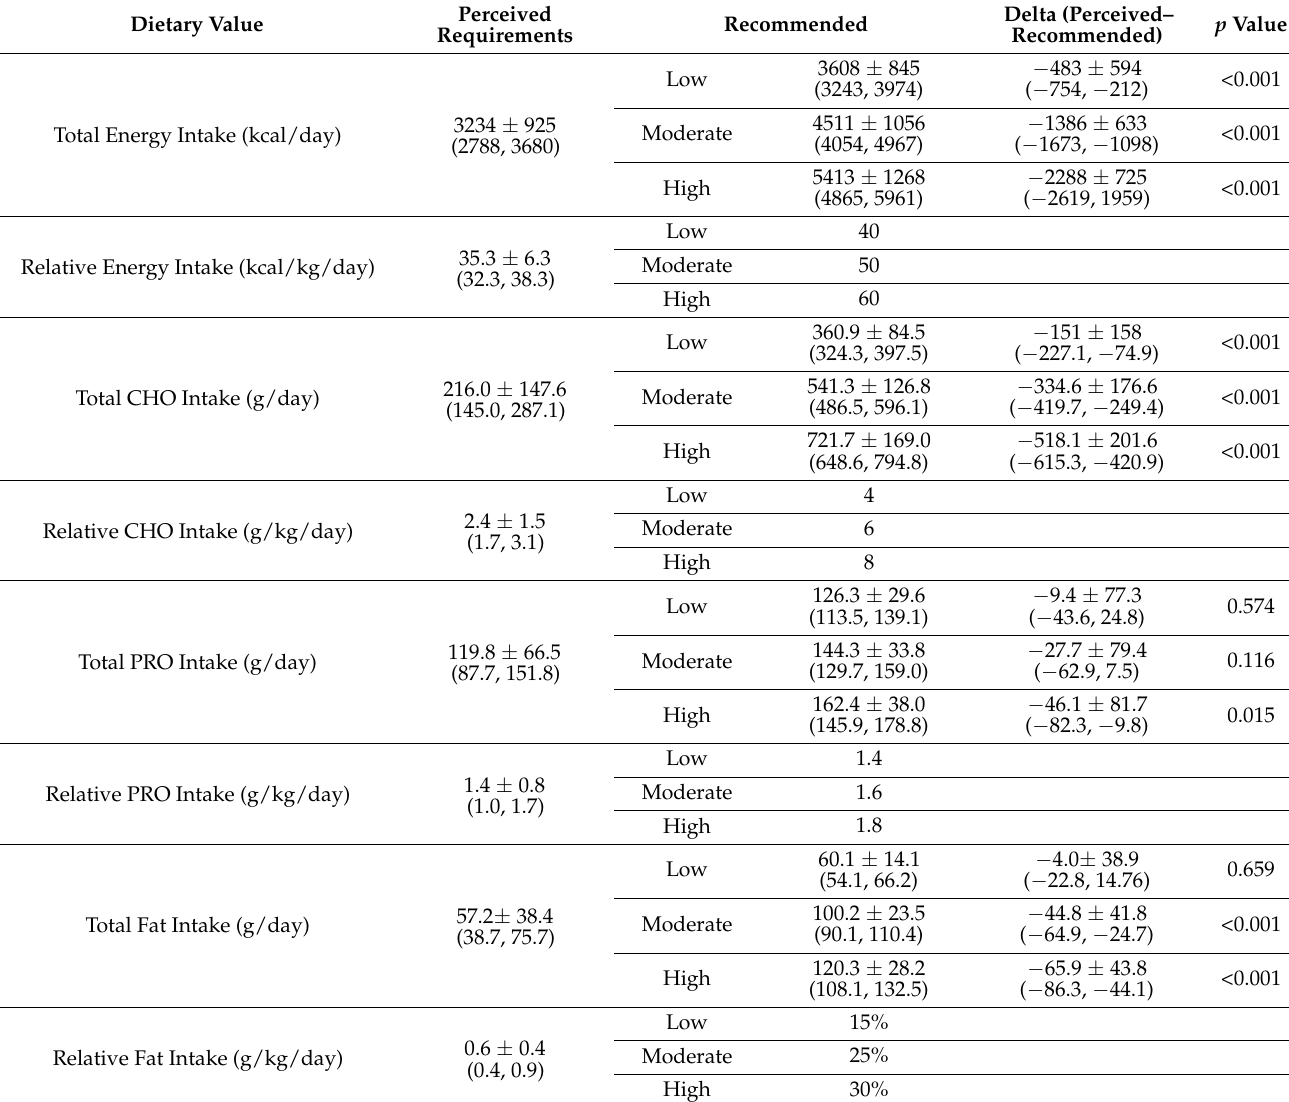
Table 2. Comparison of perceived dietary requirements versus predicted for men athletes. Perceived Dietary Value